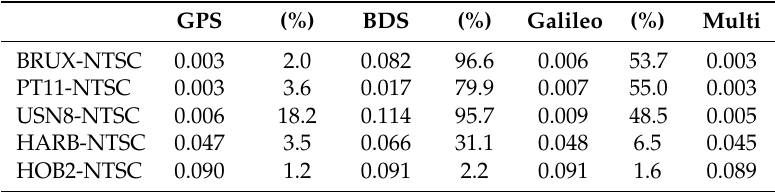
Table 3. Time link residuals compared with vondrak smoothing values using COD products (ns). GPS